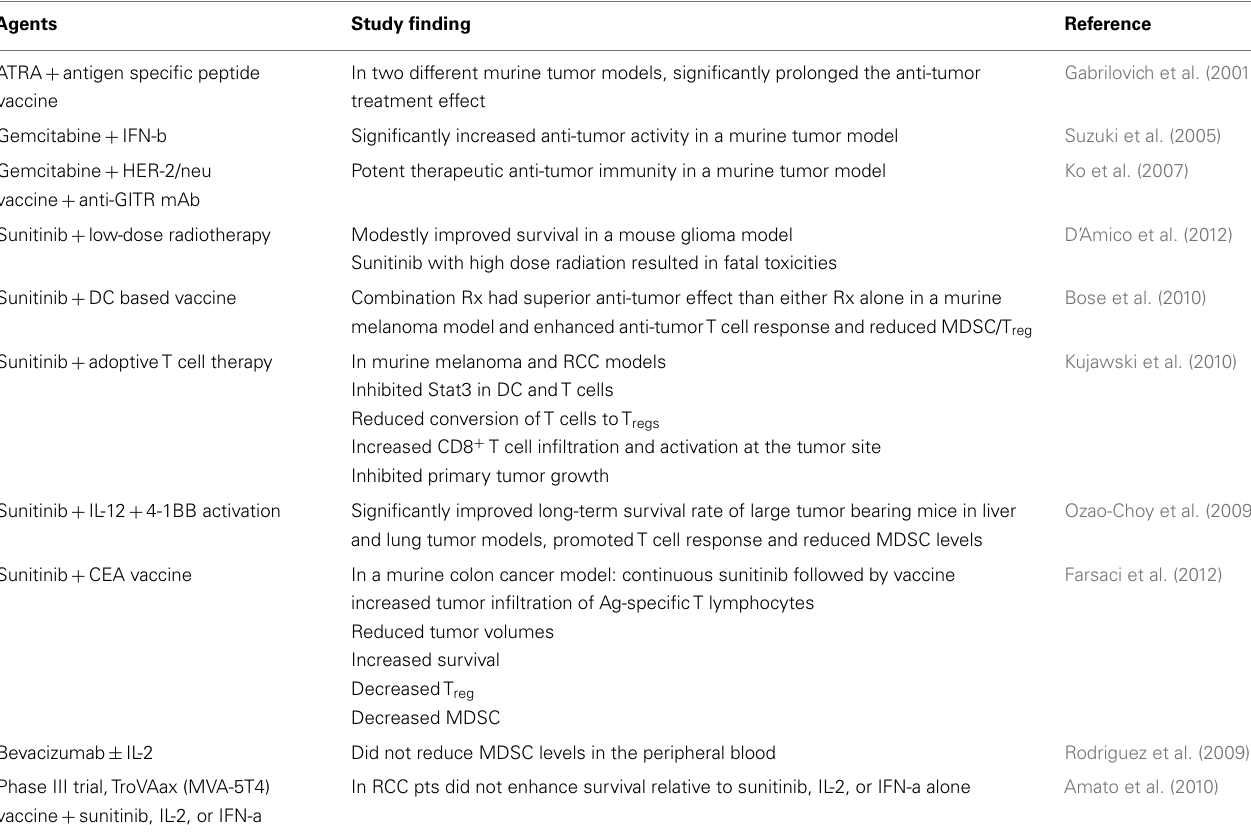
Table 2 | Summary of combination therapies targeting MDSC and key study